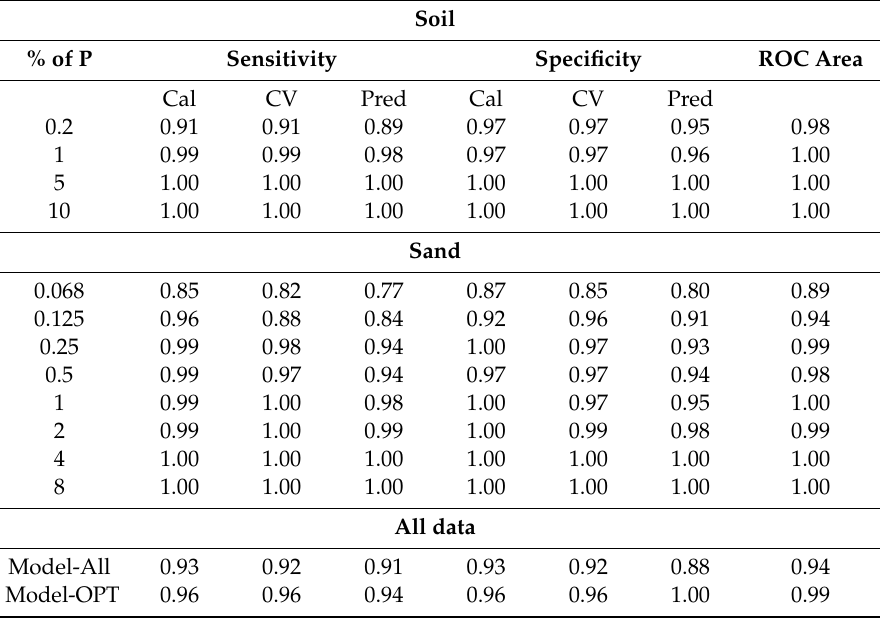
Table 1. Sensitivity, specificity, and receiver-operator curves (ROC) area for each PLS-DA model.